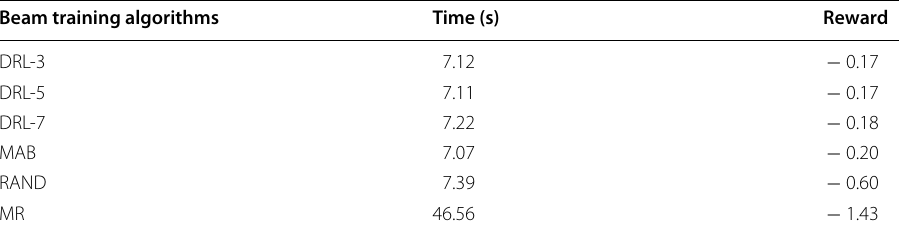
Table 8 Average runtime required to provide optimal beam pairs at T ′ different beam training